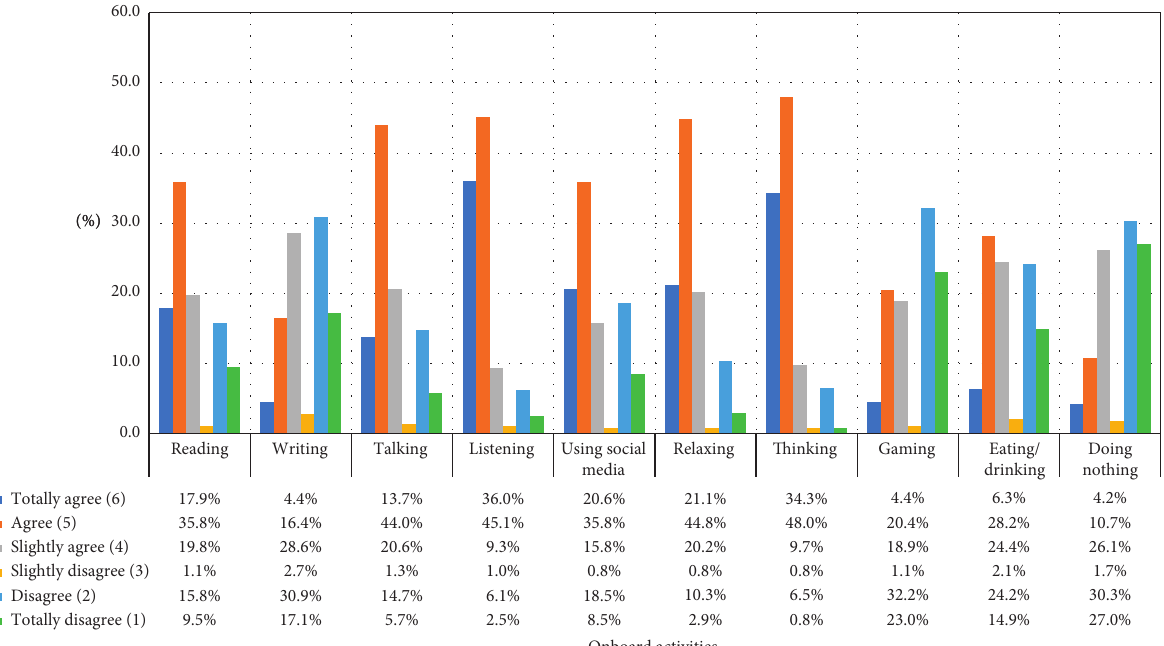
Figure 3: The participants’ responses concerning the positive impact of each onboard activity on trip